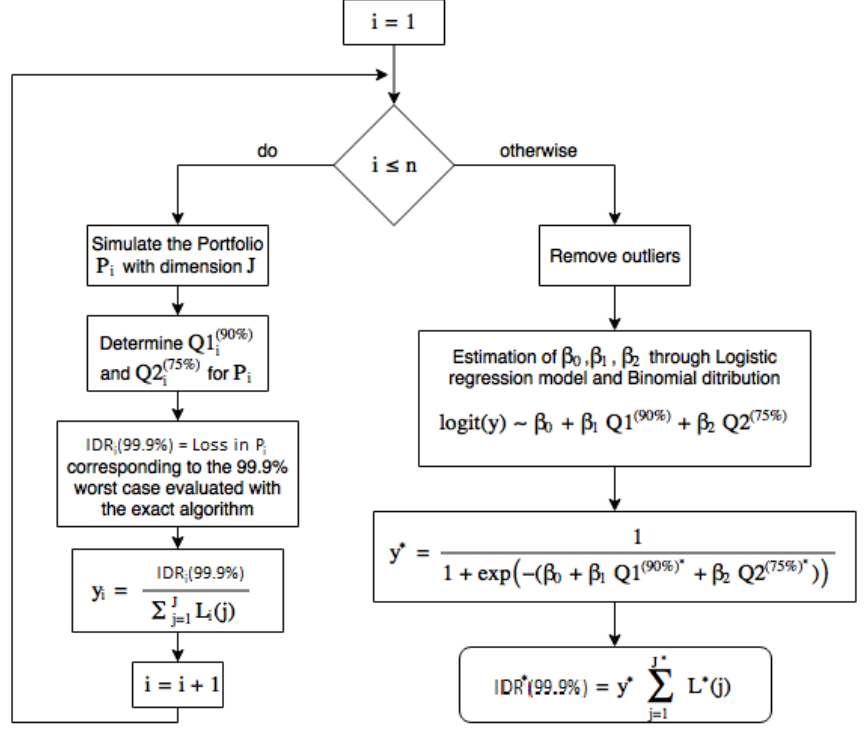
Figure 8: Flow chart of the steps for the estimation of the Portfolio Target DRC in the 99.9% worst cases. Given n , number of regression Portfolio that have to be simulated, J and J * dimension for the regression Portfolios and the Portfolio Target respec- tively, and the L * ( j ) for every issuer of the Portfolio Target and the DP * ( j ) , with j = 1, 2, . . . , J *